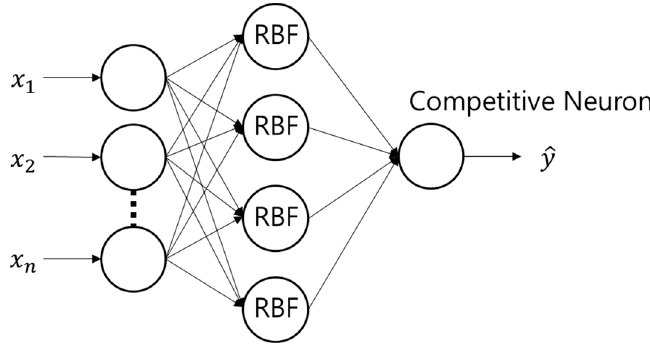
Figure 5. Probabilistic neural network. Table 1. Rainfall events for training of the